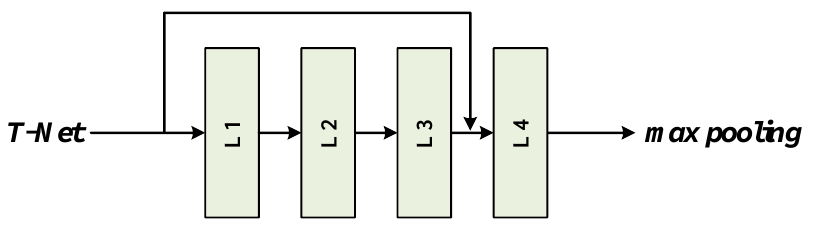
Figure 11. Skip connection layer.